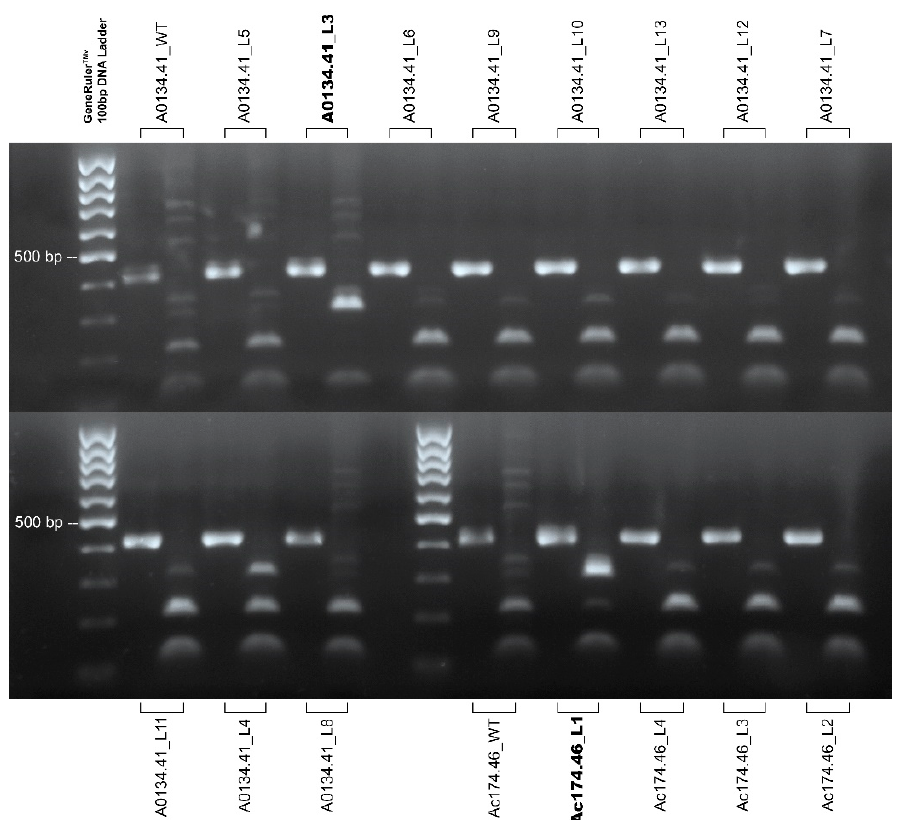
Figure 4. Agarose gel electrophoresis of the sgRNA1 target sequence PCR indigested product and their Bsl I digestion. The male genotype A0134.41 wild-type (WT), plus the 11 putative transgenic shoots obtained from this male genotype, are displayed in the upper panel of the figure and in the first three rows of the bottom panel of the figure. The male genotype Ac174.46 wild-type (WT) plus the four putative transgenic shoots obtained from this male genotype are displayed in the bottom panel of the figure. GeneRulerTM 100 bp DNA Ladder (Thermo Fisher) was used for sizing the PCR products in the range of 100 to 1000 bp on agarose gel. The plant line code of each sample is reported. The amplicon of the sgRNA1 target assay is 427 bp in length, and its Bsl I digestion produces three fragments of 221, 98, and 108 bp (the latter two bands appear as one). PCR amplification of some lines, i.e., A0134.41, wild-type (WT), A0134.41_L5, and Ac174.46 wild-type (WT), co-amplifies a second sequence that results in the presence of two extra-bands in the restriction pattern. Thirteen of these plants exhibited a restriction pattern compatible with the wild-type , showing a fragment of 221 bp. The same assay on an edited sequence provides a different digestion pattern, producing two fragments (320 and 108 bp). The edited lines are reported in bold. Image for illustrative purpose. The original image is reported in Figure